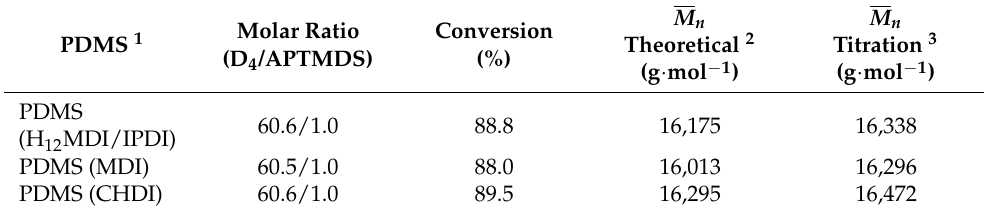
Table 1. Molecular weights of the aminopropyl-terminated PDMSs used for synthesis of PSU elastomers in this